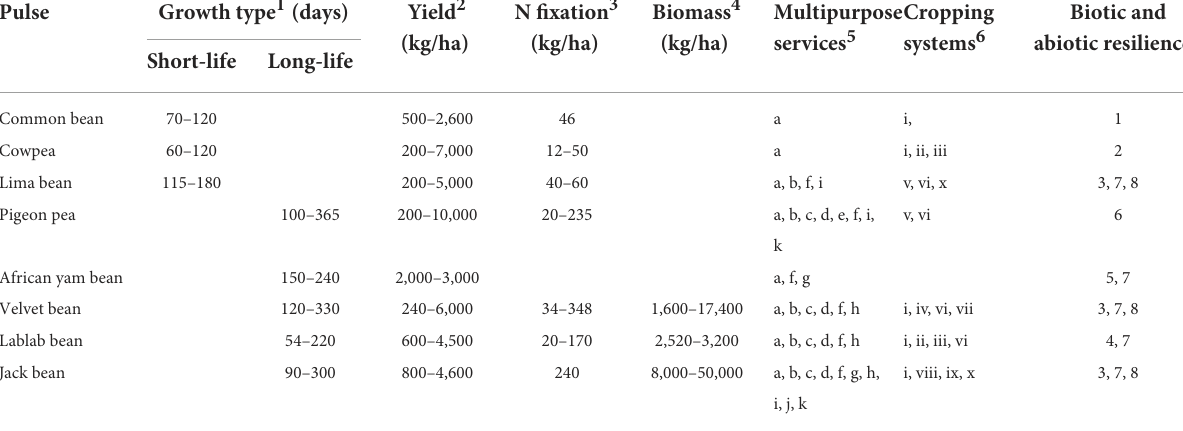
TABLE 1 Comparison of multipurpose potential between short- and long-life cycle pulses.